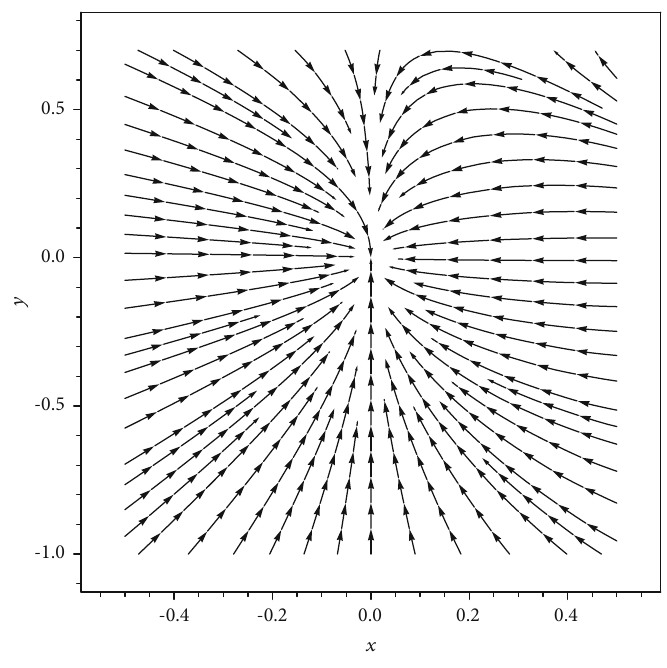
Figure 3: Shows the phase plot of the system without potential for γ = 4/3 for a stable fi xed point P .